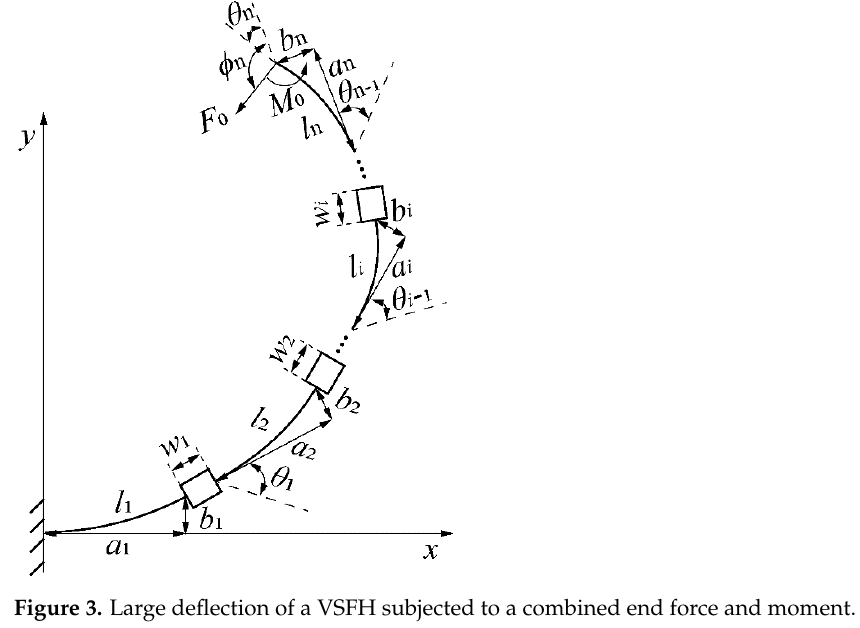
Figure 3. Large deflection of a VSFH subjected to a combined end force and moment.